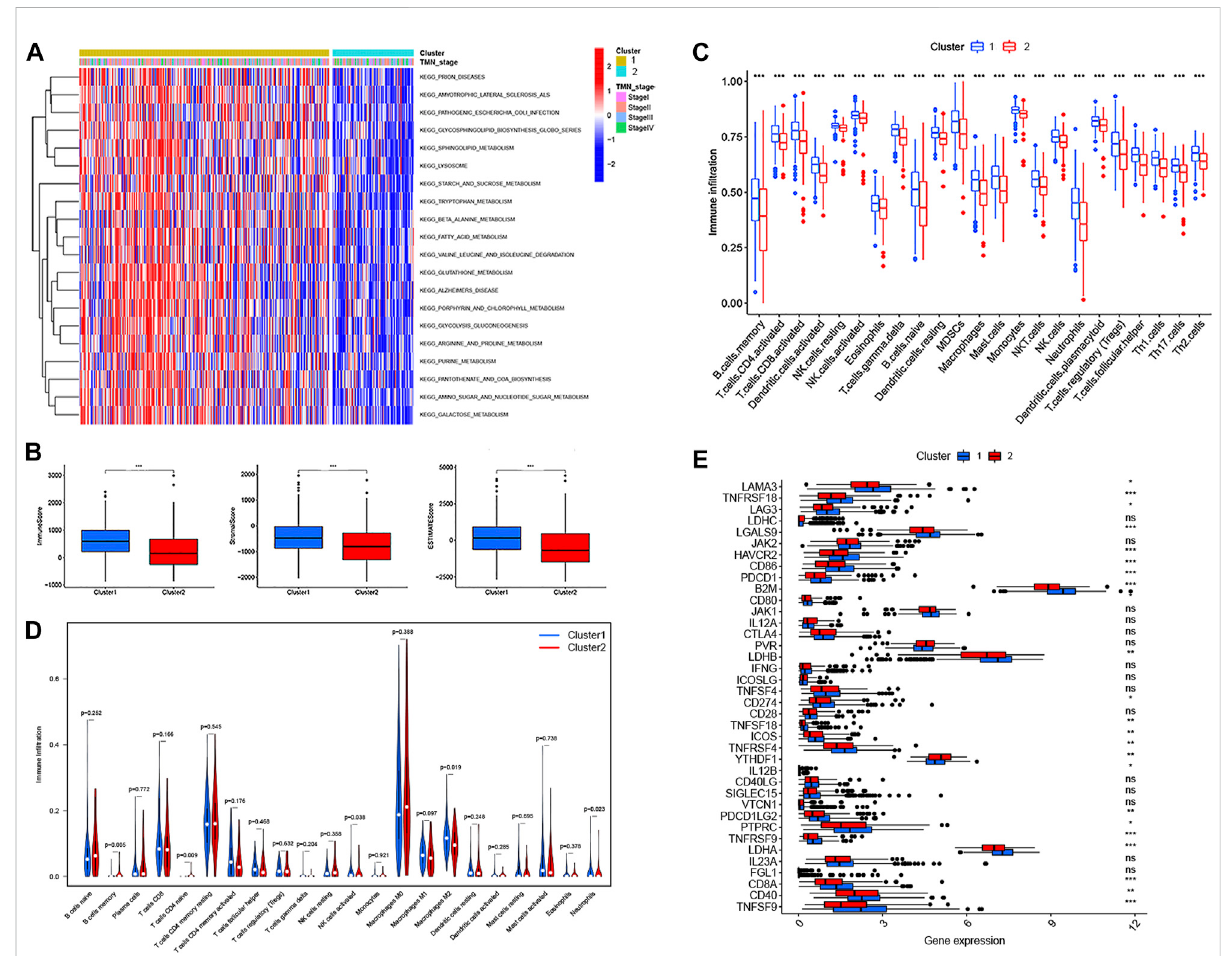
FIGURE 3 TME in fi ltration and immune-oncology targets in cluster 1/2 subtypes constructed by 28 m6A-related prognostic lncRNAs. (A) Biological processes analyzed by GSVA which showed the active biological pathways in distinct subtypes. (B) The variance analysis of ImmuneScore, StromalScore, and ESTIMATEScore in cluster 1/2 subtypes. (C) The abundance of 22 TME in fi ltrating cells between the two CRC subtypes by ssGSEAScore. (D) The differential in fi ltration levels of 22 kinds of immune cells in cluster 1/2 subtypes based on the CIBERSORT platform. (E) Expression of immune checkpoints in cluster 1/2 subtypes. * p < 0.05; ** p < 0.01; *** p <